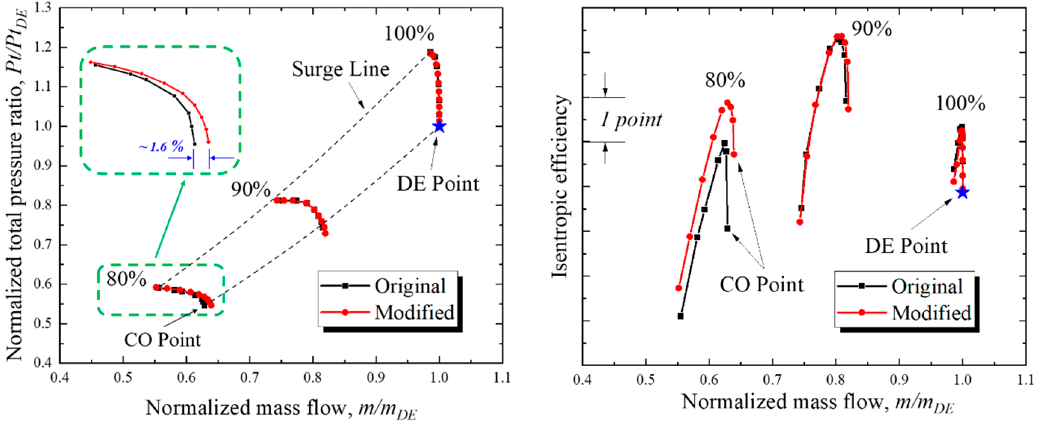
Figure 22. Characteristics of a double-stage compressor.